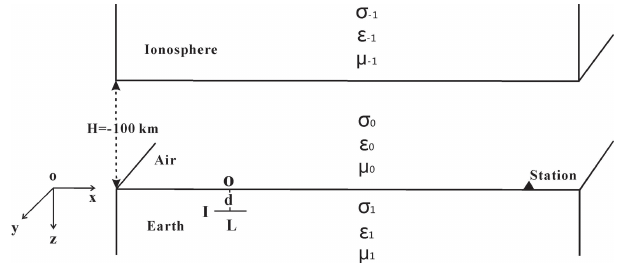
Figure 1. An x -directed dipole current source, with its central co- ordinate (0, 0, d), is placed in the bottom medium (Earth) of a three layer modeling (Earth–air–ionosphere model), where z is defined positive in the downward